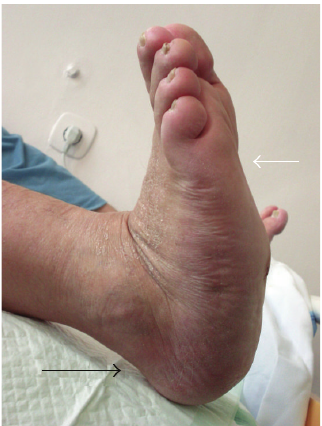
Figure 1: Clinical image of the right foot (CN) with contraction of m. triceps surae and plantar inclination of calcaneus (black arrow), instability of the foot, and dorsal collapse of the forefoot (white arrow).